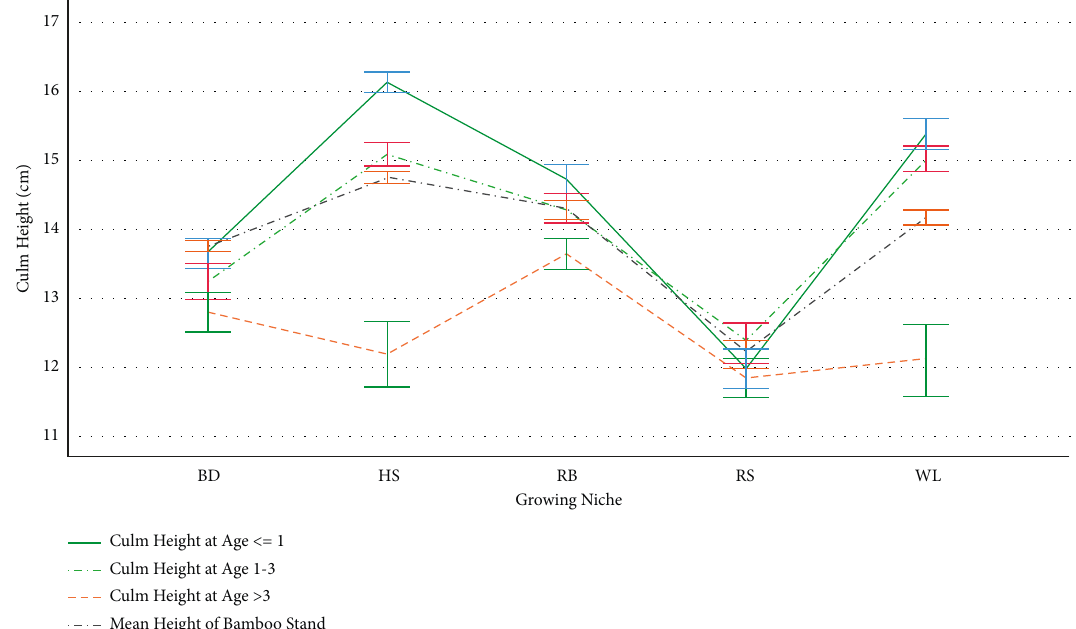
Figure 5: Height-age relationship of bamboo culms (BD � boundary; HS � homestead; RB � river bank; RS � roadside; WL � woodlot plantation